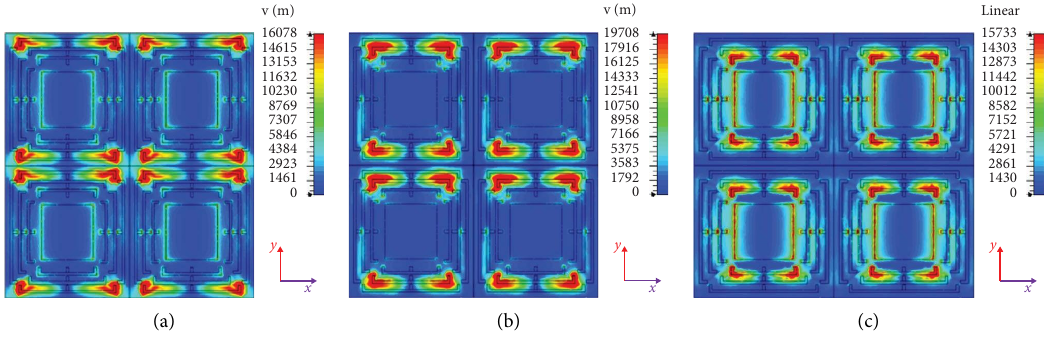
Figure 8: Surface electric feld at (a) 4.5GHz, (b) 5.8GHz, and (c) 6.5GHz.